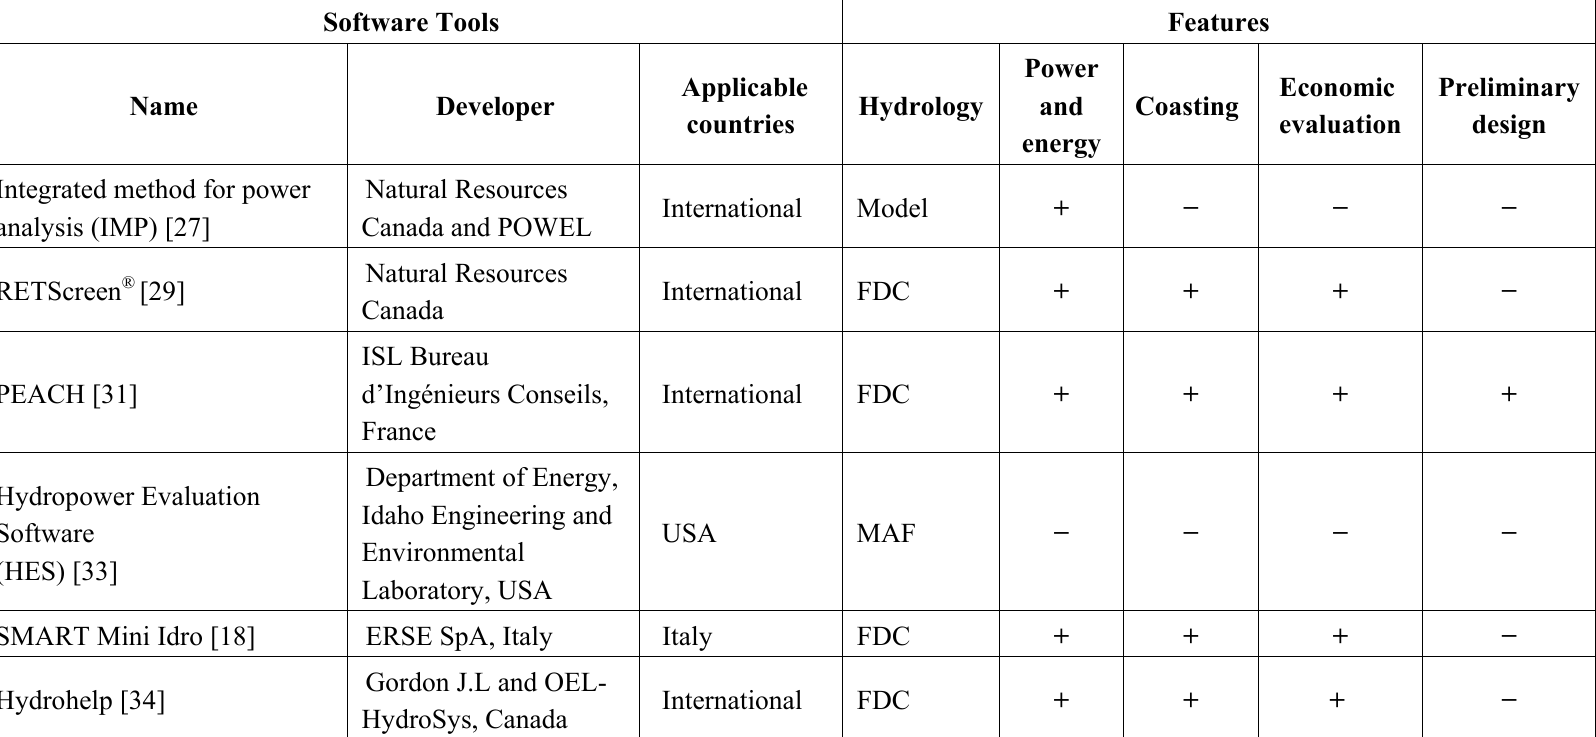
Table 1. Overview of conventional software tools for SHP